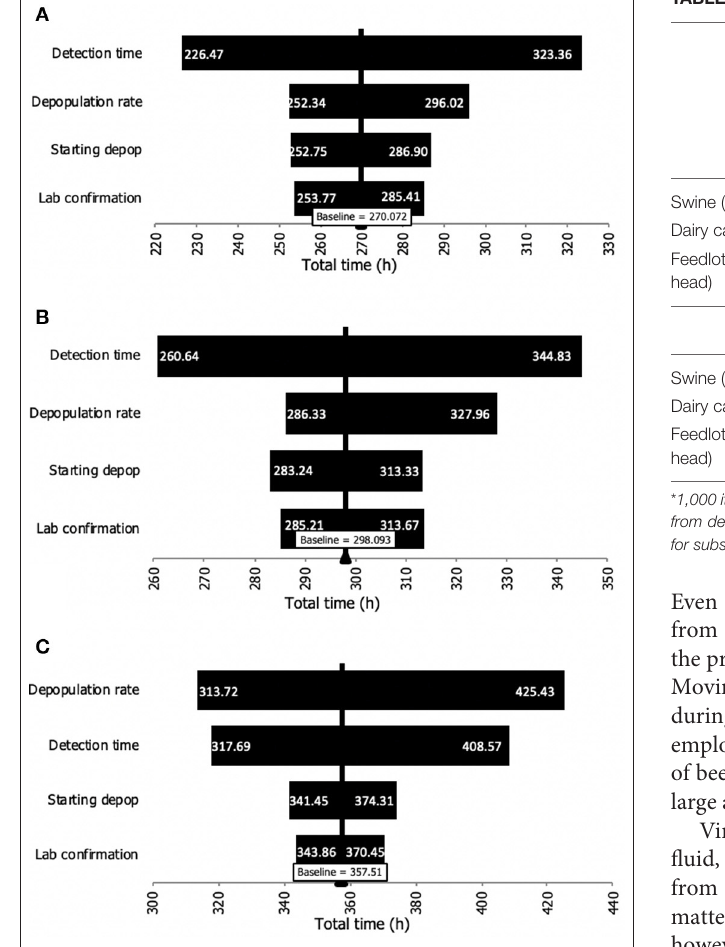
TABLE 6 | Number of viremic and recovered animals at the start of